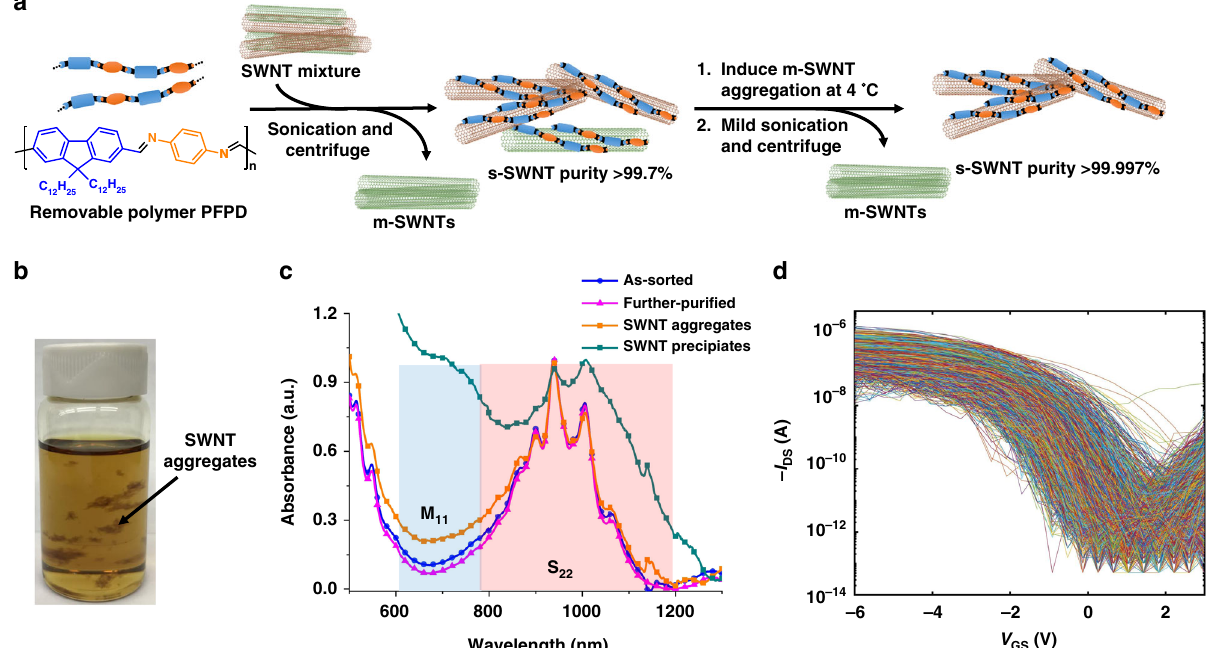
Fig. 1 CNT purity improvement by inducing further aggregation of the metallic CNTs. a Schematic presentation of the sorting process modifying our previously reported method 26 . b A photograph showing some CNT aggregates formed after the solution being stored at 4 °C for 24 h. c Absorption spectra of as-sorted SWNTs (blue), further puri fi ed SWNTs (magenta), isolated SWNT aggregates (orange), and SWNT precipitates after bath sonication of the solution with aggregates followed by centrifugation (turquoise). M 11 is the fi rst inter-band transition of m-SWNTs. S 22 is the second inter-band transition of s-SWNTs. d Electrical measurement of the fi nal puri fi ed SWNTs (device batch #2). Two batches of short-channel (500 nm) transistors were fabricated (see “ Methods ” and Supplementary Fig. 4 for details). About 34,590 CNTs were tested, we found only 1 metallic tube. The purity is thus estimated to